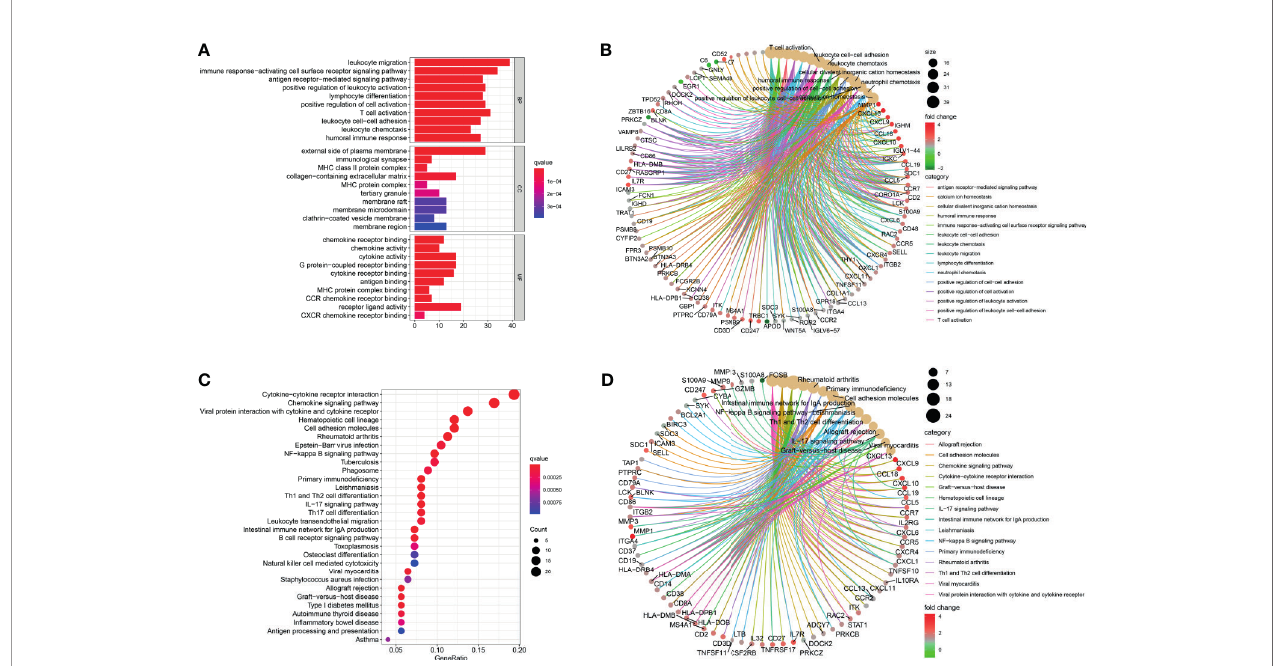
FIGURE 5 | Functional correlation analysis. DEGs were analyzed by GO and KEGG. (A, B) The results of GO were presented by bar plot and circle charts. (C, D) The results of KEGG were shown by bubble and circle